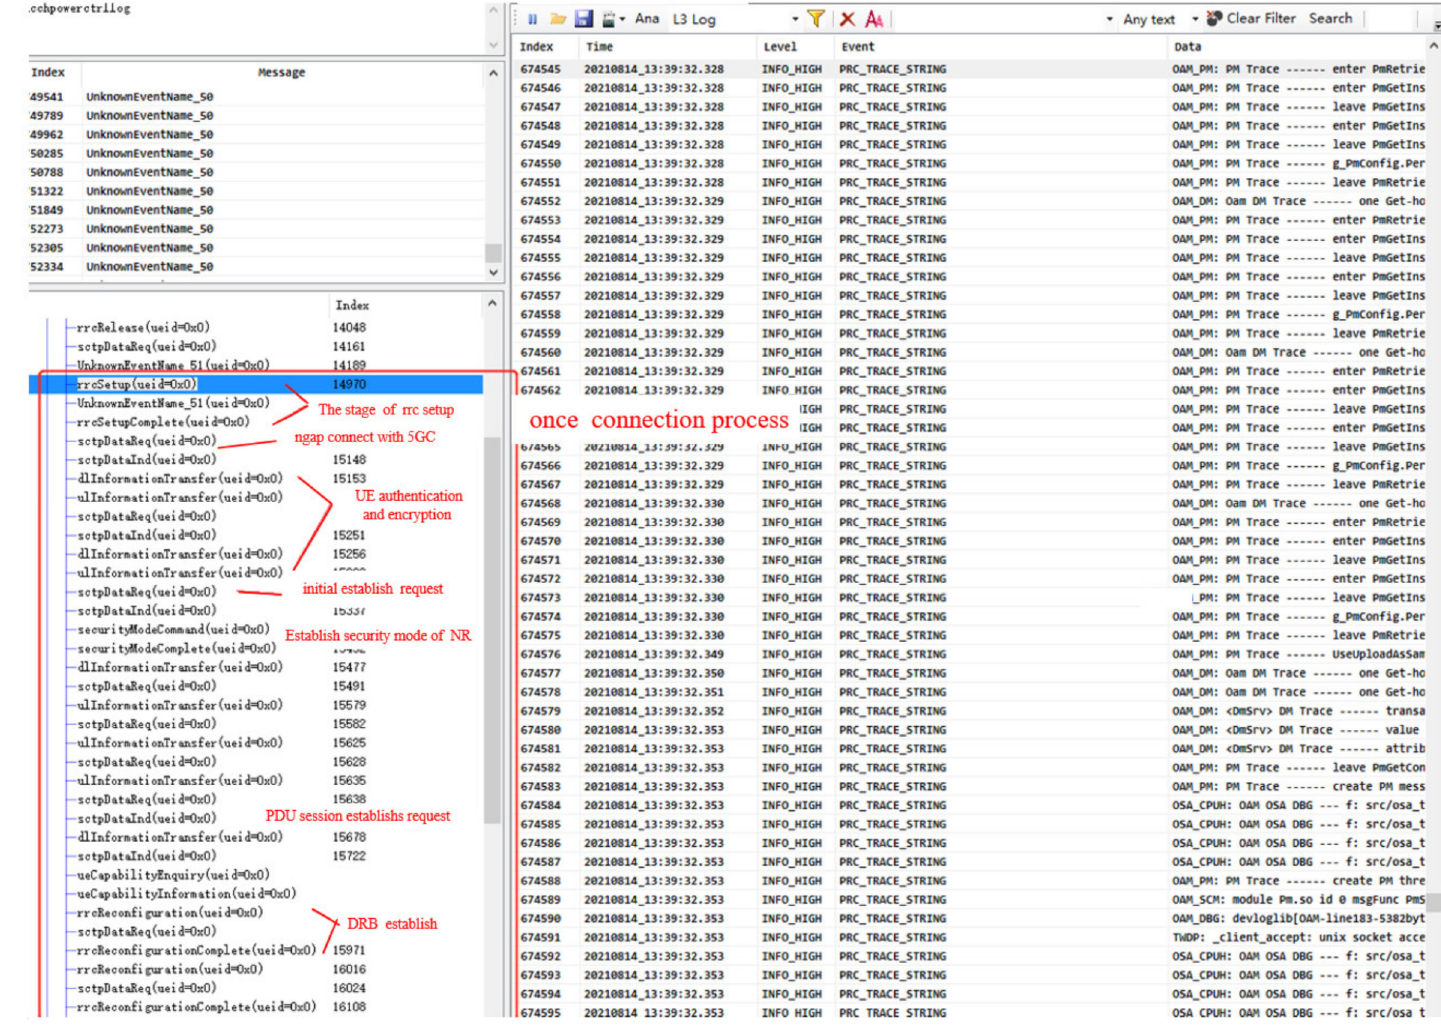
Figure 10. Screenshot of successful